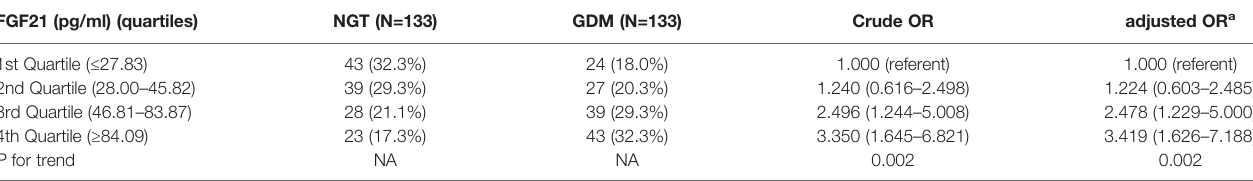
TABLE 2 | Associations of serum FGF21 concentrations (pg/ml) early in the second trimester of pregnancy with the risk of gestational diabetes mellitus. FGF21 (pg/ml) (quartiles) NGT (N=133) GDM (N=133) Crude OR adjusted OR a 1st Quartile ( ≤